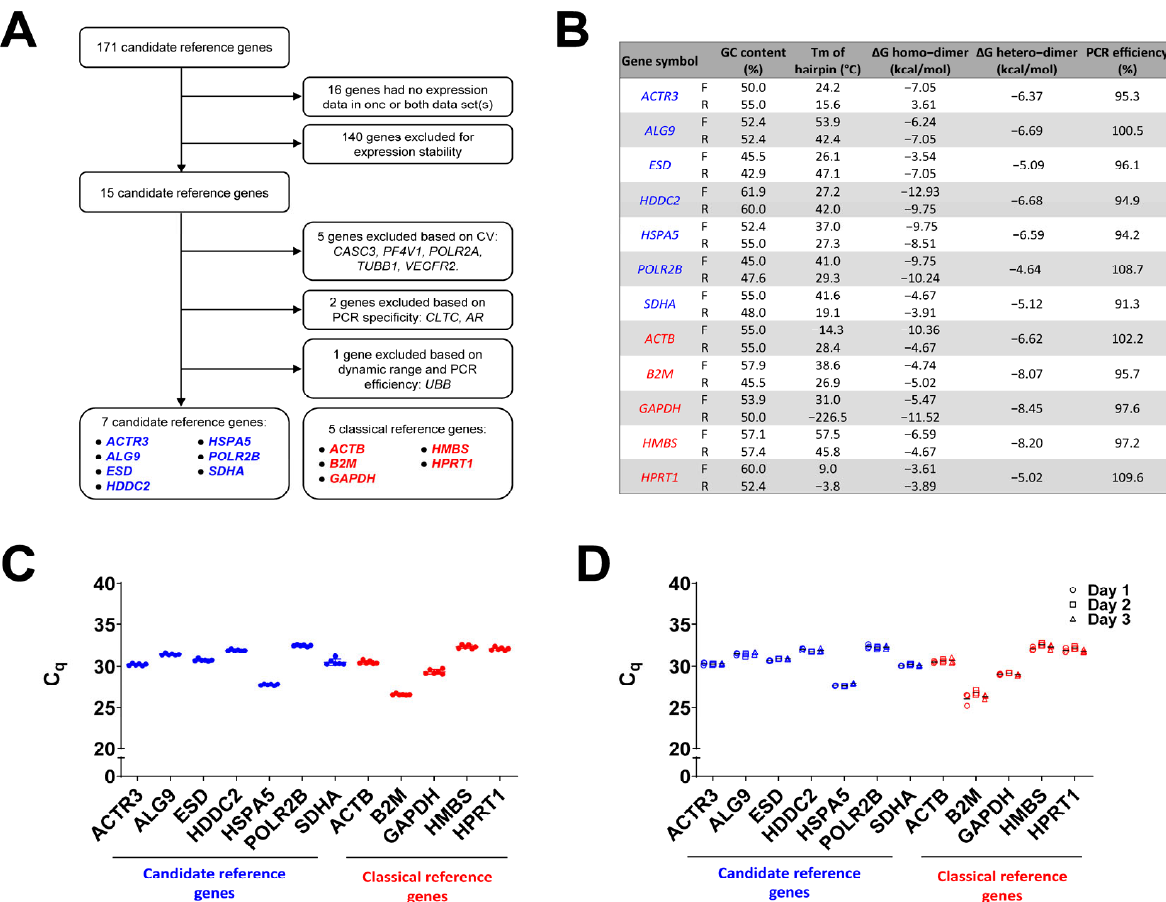
Figure 2. Assay validation for candidate reference genes and the “classical” reference genes . ( A ) The flow chart shows the selection process of candidate reference genes from the initial list of 163 candidates from the systematic search, based on in silico stability analysis (based on adjusted p ‐ values and coefficient of variation, CV) and subsequent experimental validation of PCR assays (based on PCR efficiency and dynamic range) until the identification of the seven best ‐ performing candidate reference genes (in blue), whose levels, along with the levels five “classical” reference genes (in red) are explored in AL amyloidosis and control subjects for subsequent analysis. ( B ) The table shows the most relevant parameters impacting on qPCR performance of each of the 12 primer pairs (F: forward primer; R: reverse primer) identified for each of the investigated genes (candidate reference genes in blue; “classical” reference genes in red). ( C ) C q values of six technical replicates, represented by dots, for each candidate reference gene (in blue) or “classical” reference gene (in red) obtained within one single run (intra ‐ assay variation). Horizontal lines denote the mean value for each group. ( D ) C q values of three technical replicates for each candidate reference gene (in blue) or “classical” reference gene (in red) obtained in three different runs on separate days (inter ‐ assay variation). Each symbol (circle, triangle, and square) indicates a different assay/day. Horizontal lines denote the mean value for each group.